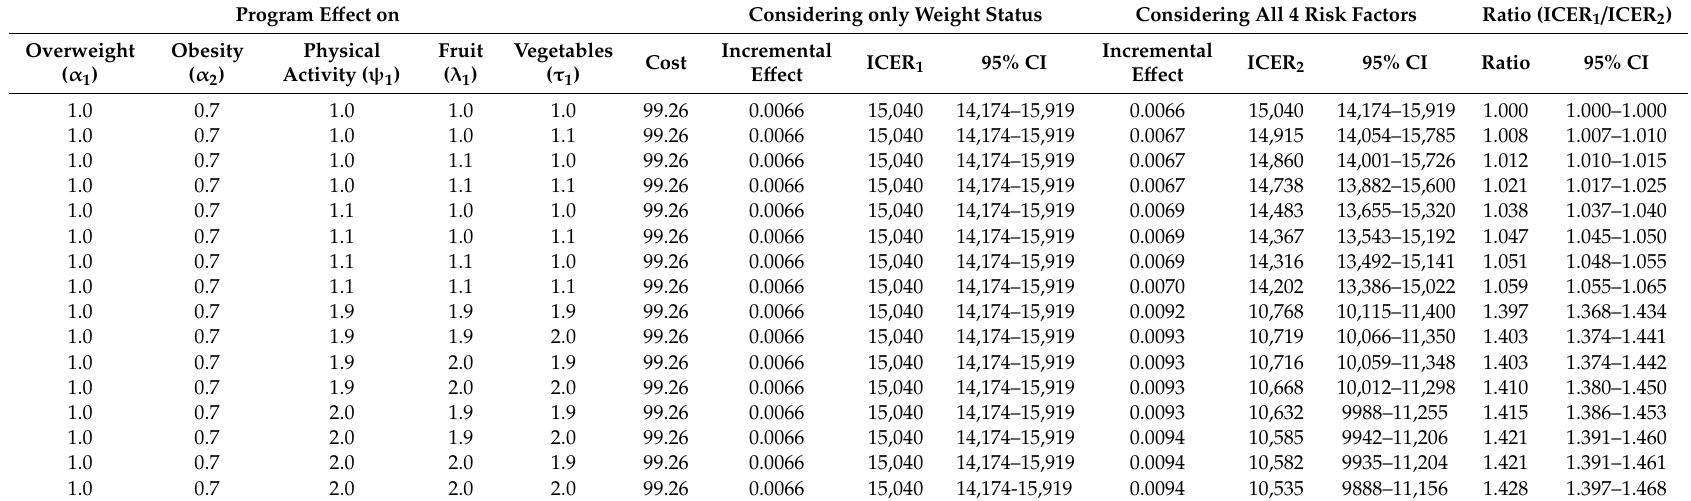
Table 2. Estimated incremental cost-e ff ectiveness ratio (ICER) for Quality Adjusted Life Years (QALYs) gained, considering e ff ects on all four risk factors compared to the e ff ect on weight status